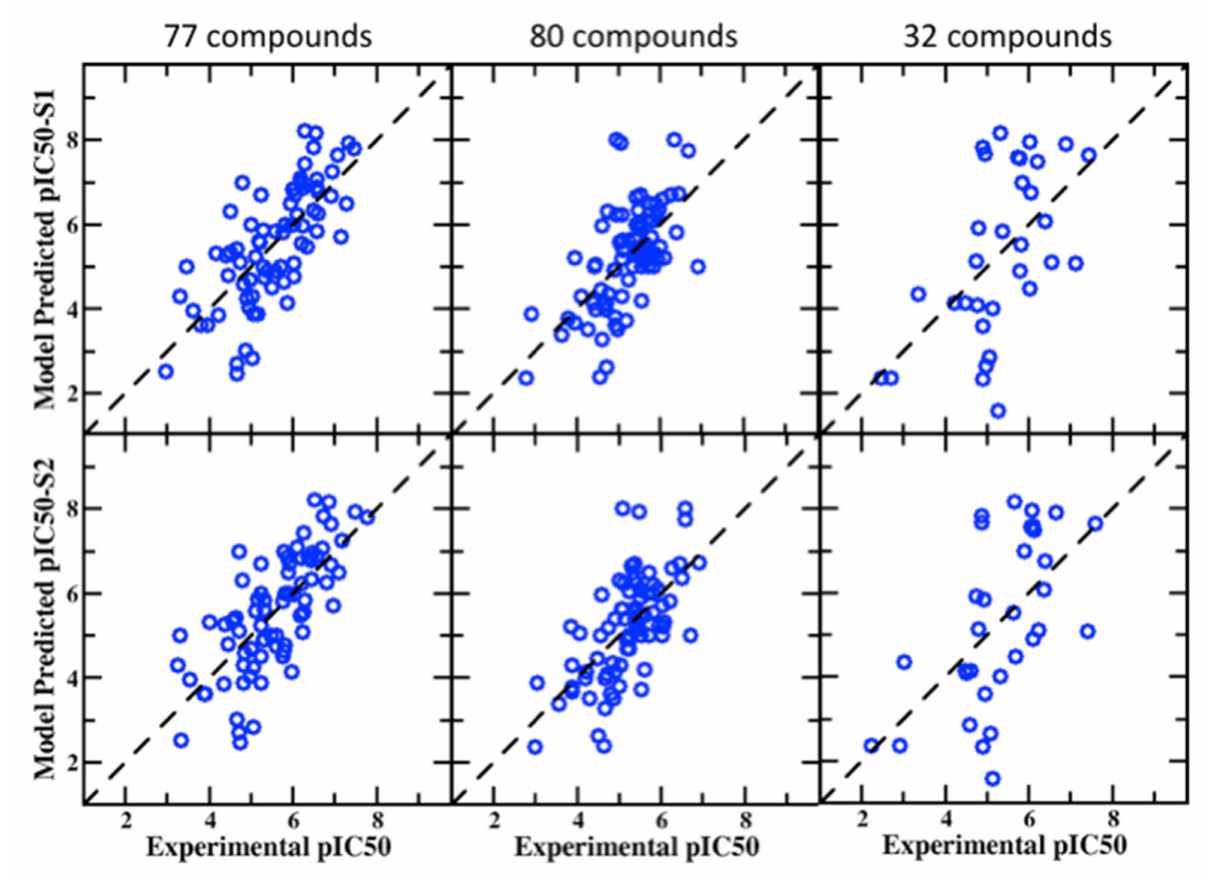
Figure 2. Correlation plots between experimental and predicted pIC50 values from the BML PPM + SILCS LGFE score consensus model for the 77, 80, and 32 compounds in the S1 ( top row) and S2 ( bottom row) pockets in the hERG